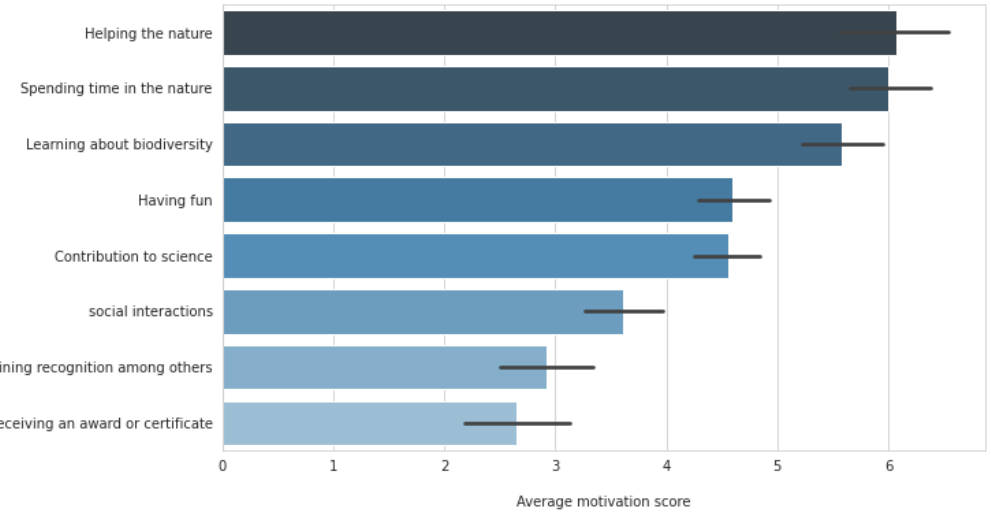
Figure 8. Motivation ranking to participate to BioPocket project [83]. Motivating factors were given scores from 1 to 8, and the ranking was based on the average score give to